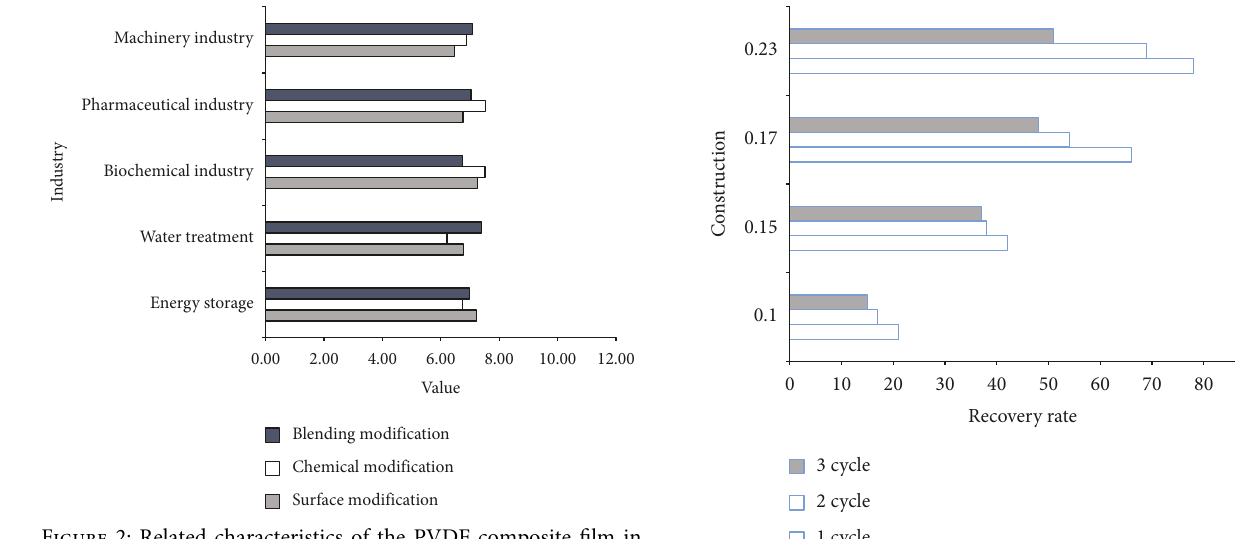
Figure 2: Related characteristics of the PVDF composite film in different fields.